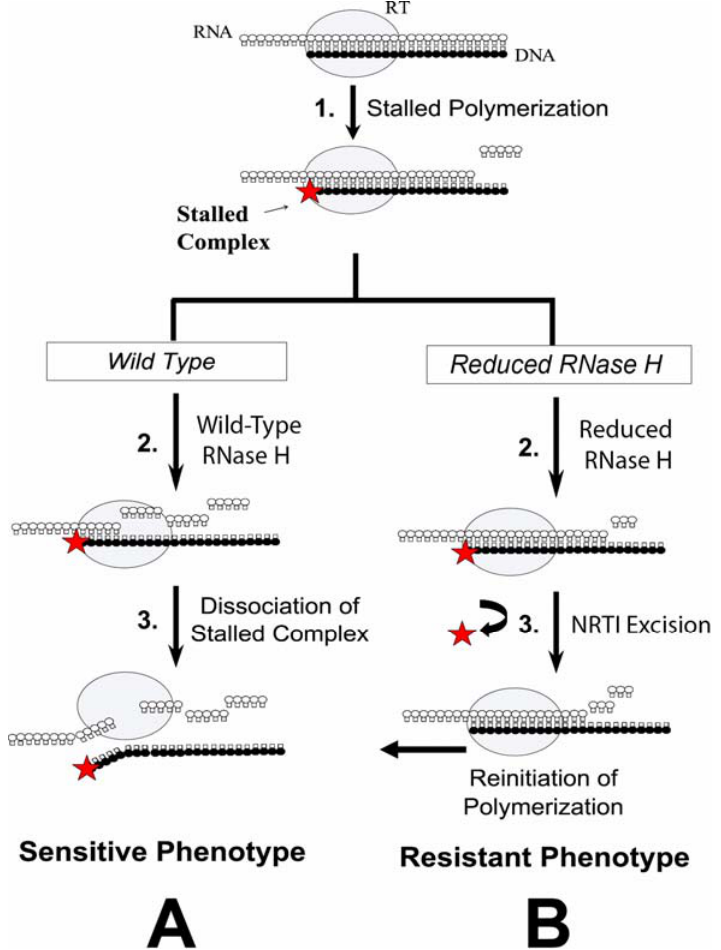
Figure 3. Mechanisms of C-terminal domain NRTI resistance. During reverse transcription, incorporation of AZT leads to a complex stalled for polymerization. (A) In the case of a wild-type RT with wild-type RNase H activity, the stalled complex leads to a dissociation of the complex and sensitive phenotype as RNase H cleavage causes minimal stretches of homology to be retained between the RNA/DNA hybrid. (B) In the case of an RT with reduced RNase H activity, the decrease in template RNase H cleavage allows longer stretches of homology to be retained between the RNA/DNA hybrid giving more time for the pol active site to undergo nucleotide excision and reinitiate polymerization, leading to a resistant phenotype. Gray oval, reverse transcriptase; star, AZT; white circles, RNA; black circles,